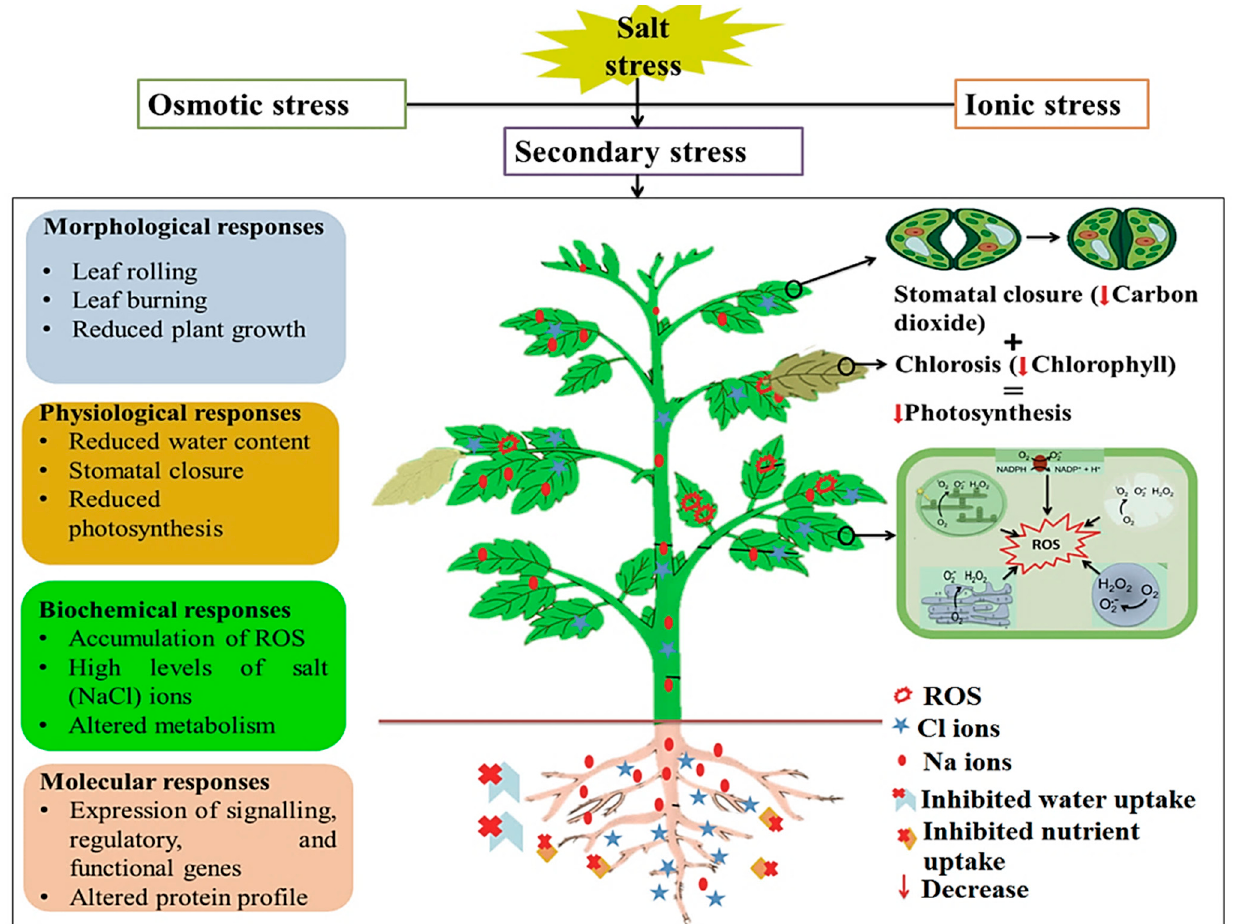
Figure 1. Summarised morphological, physiological, biochemical, and molecular responses to salinity stress. Accumulation of ions, mainly sodium (Na + ) and chloride (Cl − ) ions, in the soil inhibit water and nutrient absorption, leading to impaired cellular water status (osmotic stress) and an extreme case of ion toxicity. In addition to an overproduction of macromolecule-damaging reactive oxygen species (ROS), the resultant secondary effects of salinity stress entail stomatal closure, reduced water content, and chlorosis, hence a reduced rate of photosynthetic activity.